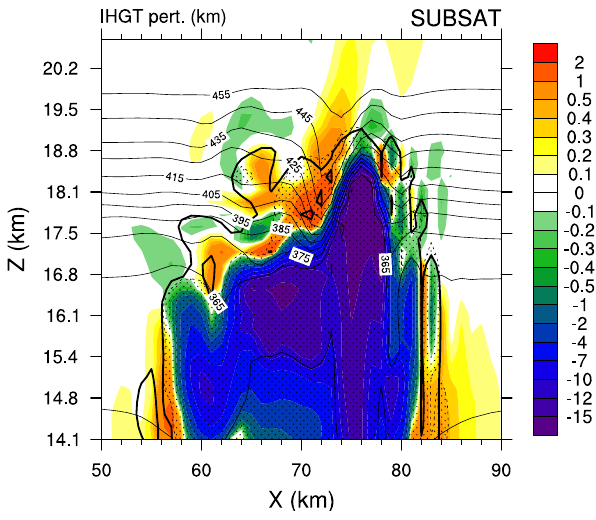
Fig. 11. Vertical cross-section of IHGT tracer perturbation for the SUBSAT case at 40min (across y = 80km). Negative values indi- cate that parcels have originated from below while positive values indicate parcels from above. The thick black line represents the total cloud mixing ratio of 0.01gkg − 1 (and marks the cloud boundary). Potential temperature isolines, contoured every 10K between 355– 455K, are overlaid. Stippled regions correspond to where parame- terised TKE per unit mass exceeds 0.05m 2 s − 2 to indicate non-zero mixing within and near the cloud